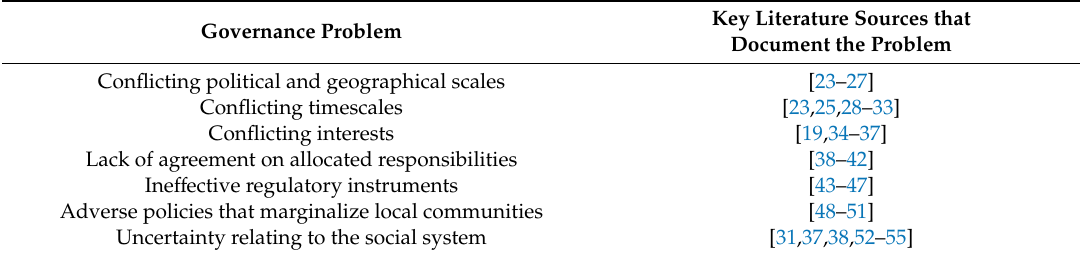
Table 2. Key governance problems identified in the literature